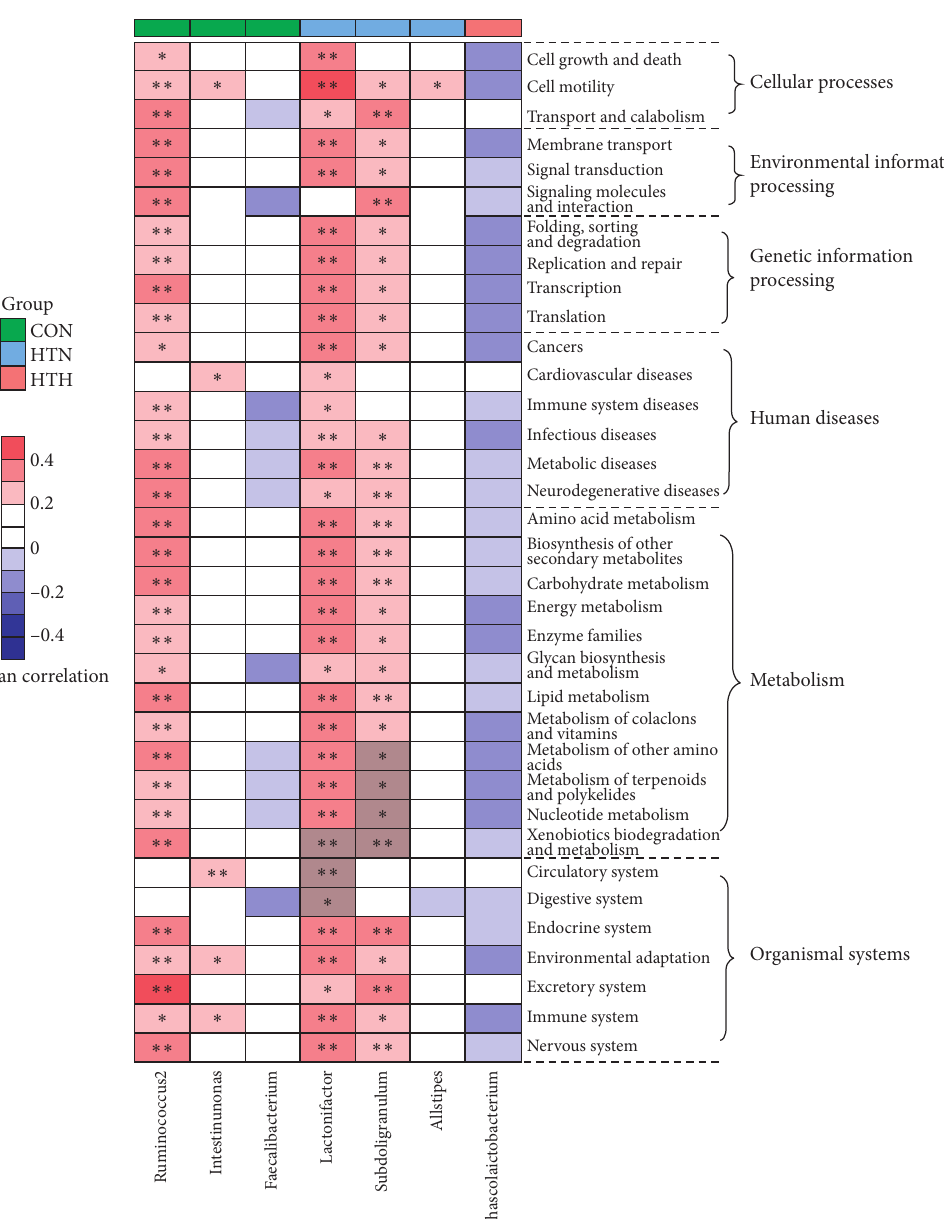
Figure 4: Heatmap of spearman’s correlation between enriched bacterial taxa and KEGG pathways according to clustering of three groups. Spearman’s correlation coefficients were calculated and are shown in the left, with red representing a more positive and blue being more negative correlation. The clustering of the control group (green box), HTN group (blue box), and HTH (red box) are presented. ∗ Spearman’s correlation is significant with P < 0 .